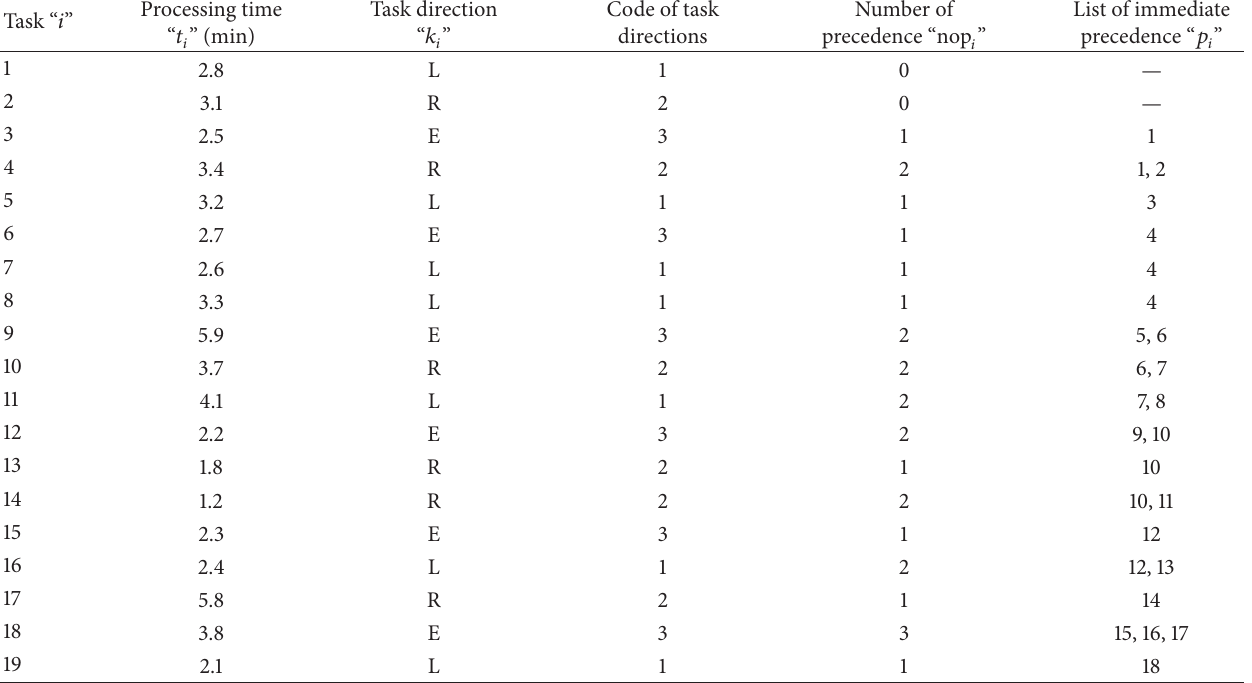
Table 1: Input data of P19 TALBP.